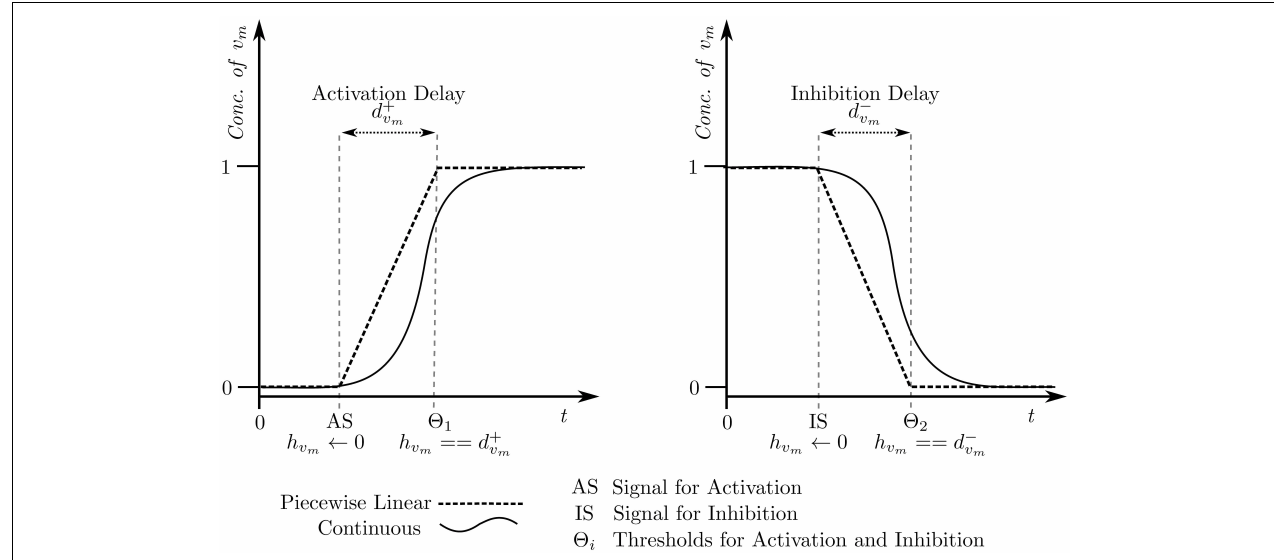
FIGURE 6 | Piecewise affine linear approximation of the continuous evolution of the entity, forming the basis of the hybrid model.